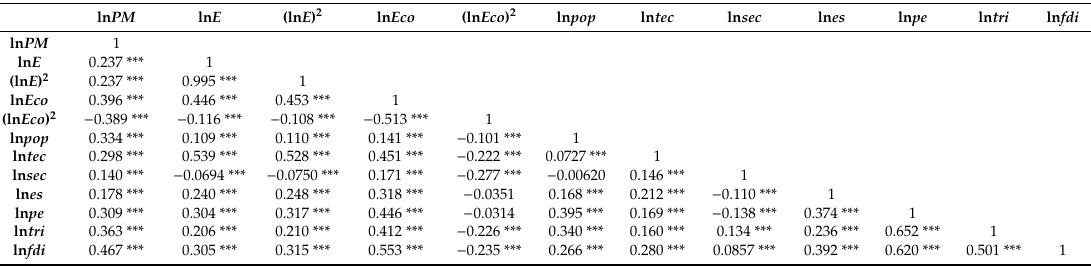
Table A1. Correlation coe ffi cient of each